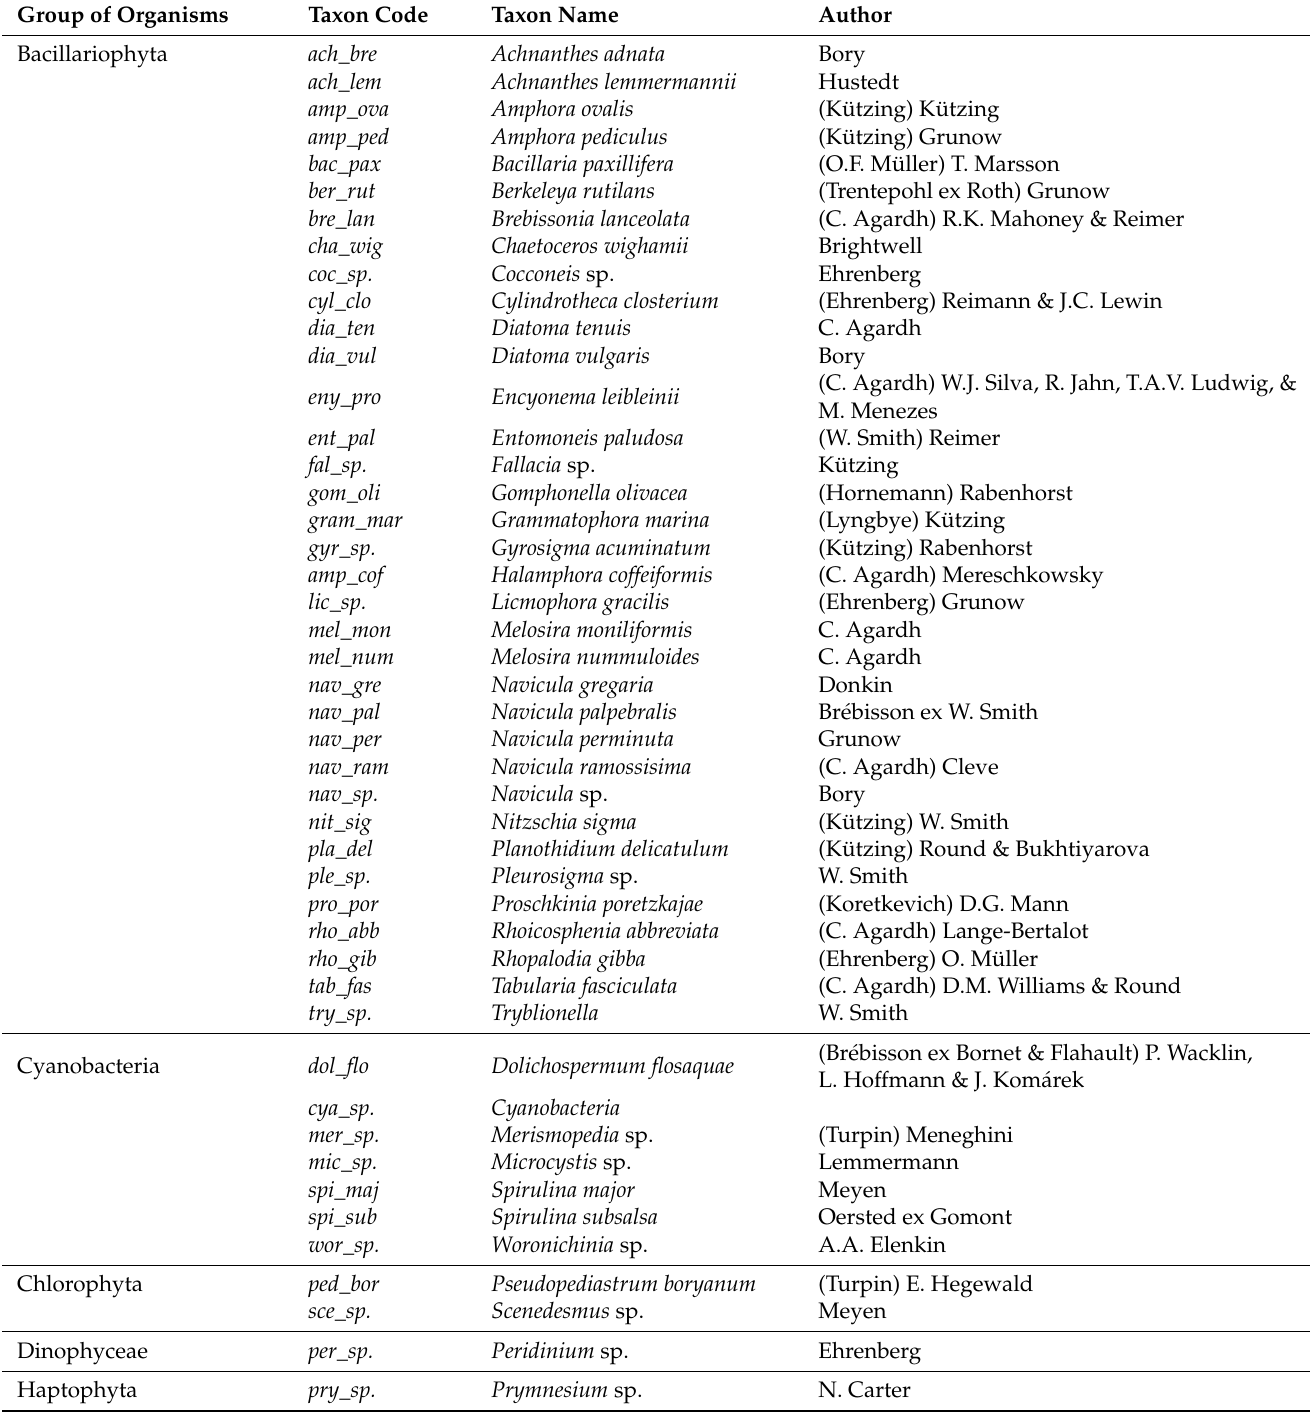
Table A1. List of taxa identified in the studied microphytobenthic communities with codes used in statistical